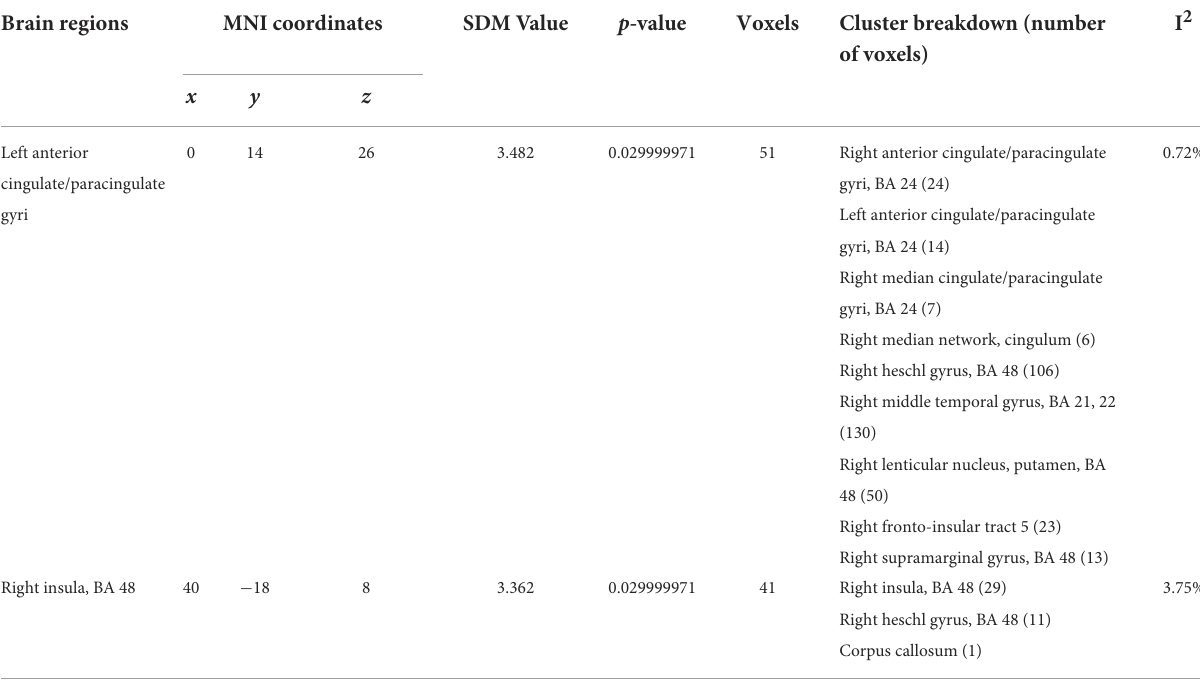
TABLE 4 Regional differences in brain gray matter volume activity before and after acupuncture treatment in cross-sectional and longitudinal studies. Brain regions